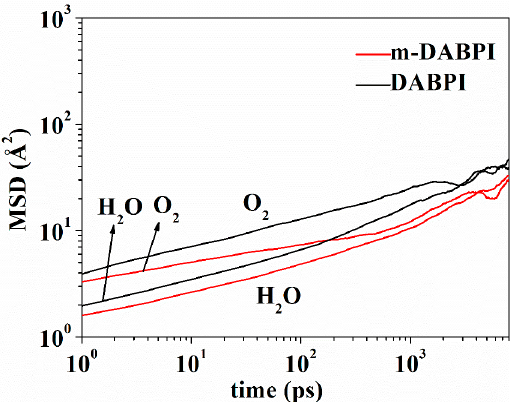
Figure 11. MSD of O 2 and H 2 O in DABPI and m-DABPI as a function of time. Table 5. Simulated diffusion coefficients (D), solubility coefficients (S), and permeability (P) for O 2 and H 2 O in DABPI and m-DABPI.